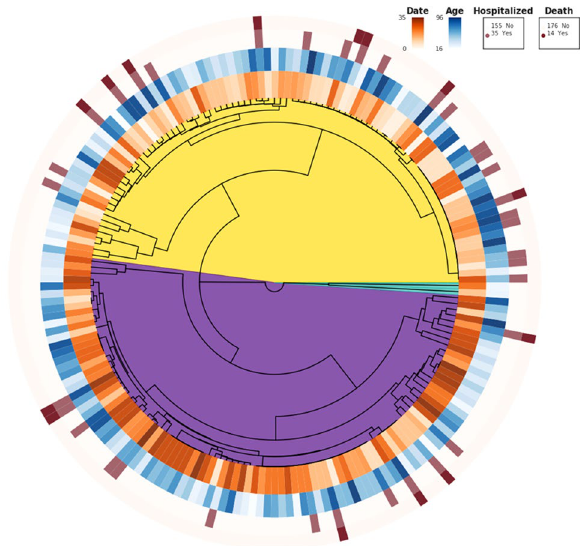
Figure 2. Outcomes of COVID-19 in cohort, divided by viral clade. Color code and dendrogram as in Fig. 1. Date refers to relative date of sample acquisition over 35 days, darker color is more recent.